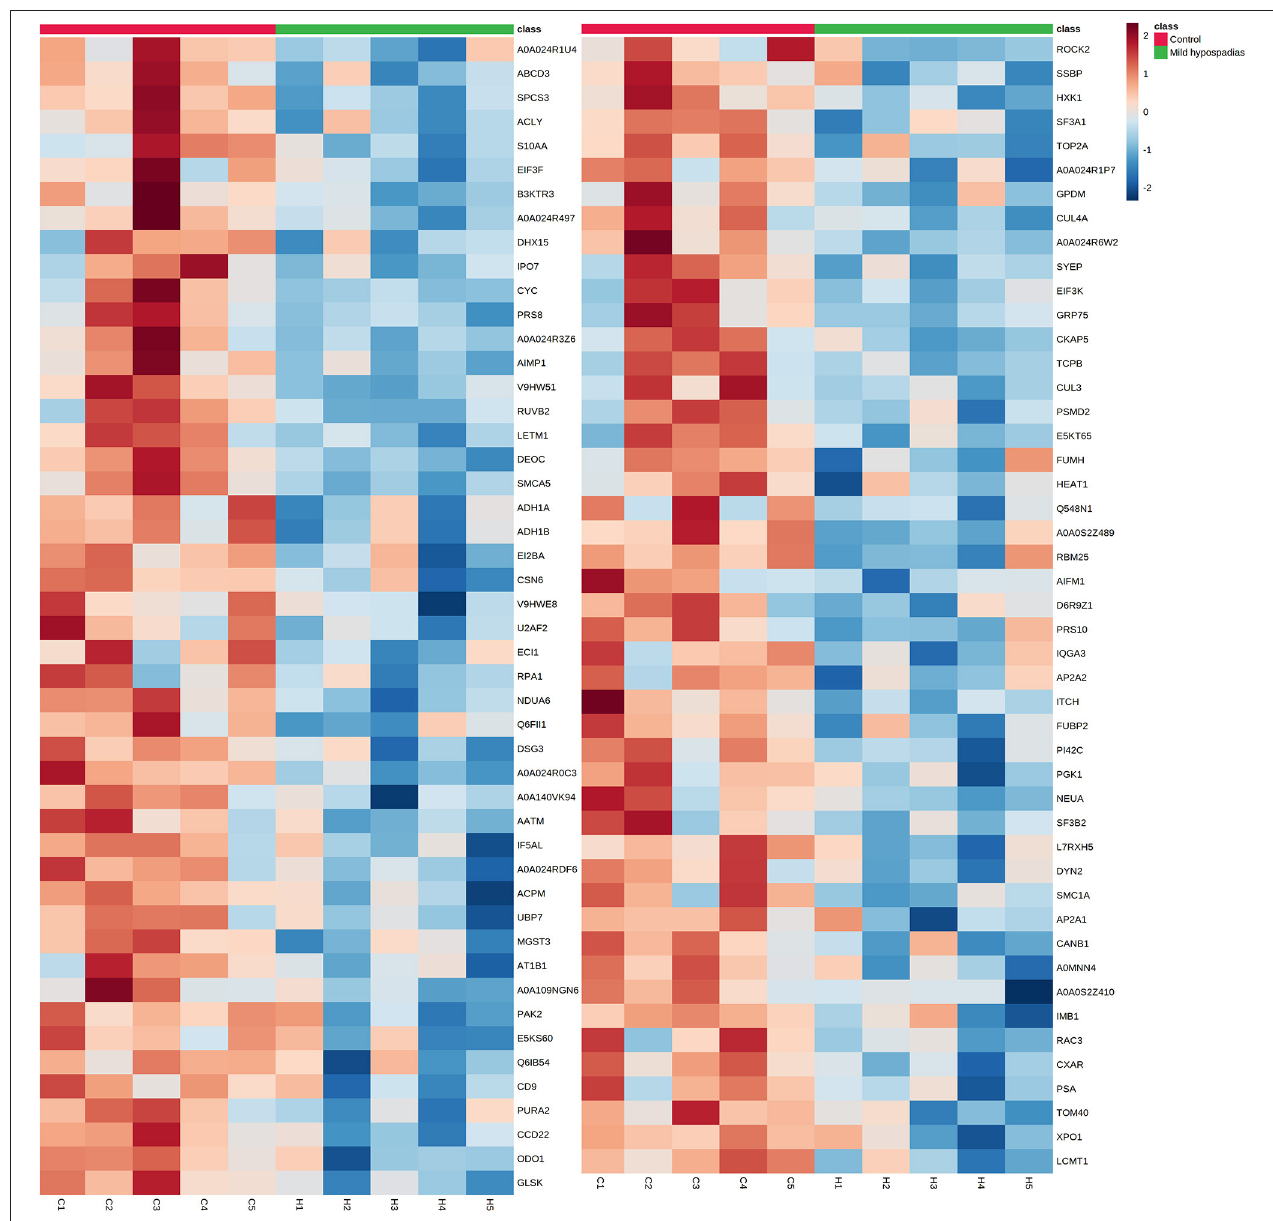
FIGURE 3 | Proteins found downregulated in the proteome from mild hypospadias patients. Ninety-five proteins were found decreased between control and mild hypospadias samples. Heatmaps depict protein abundance changes in terms of Zq across samples (C1-C5 for control and H1-H5 for mild hypospadias samples). The magnitude of abundance change [increased (red) or decreased (blue)] is shown according to the color scale on the right.